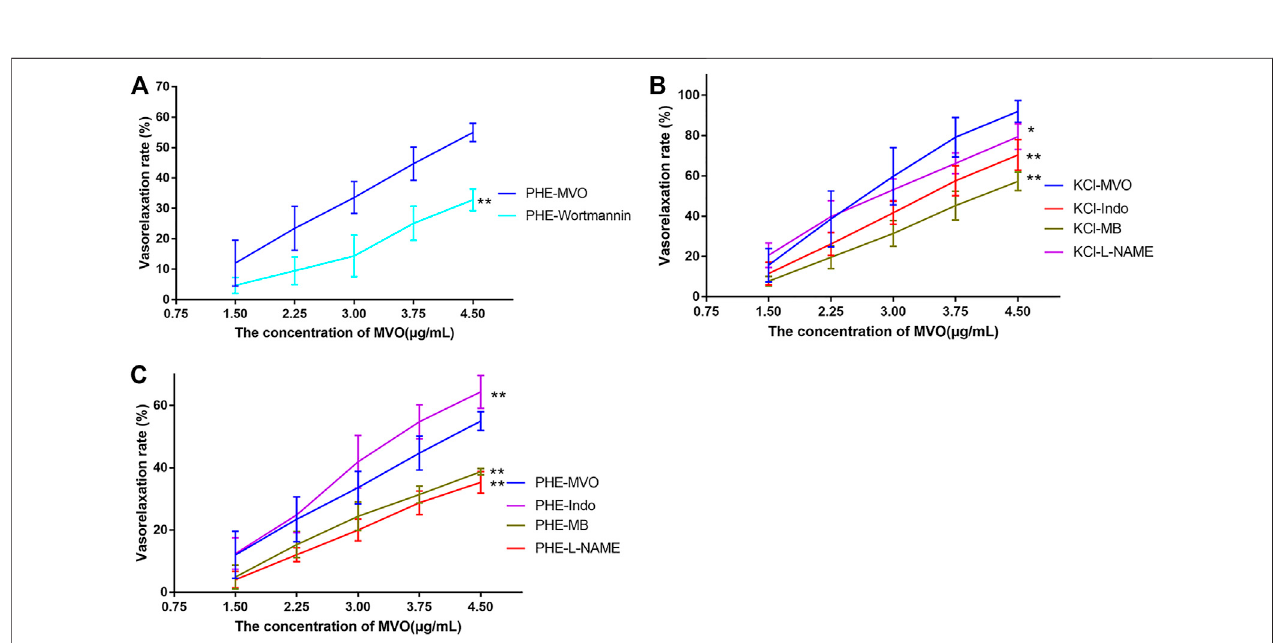
FIGURE 7 | Effects of MVO on rings pre-incubated by different inhibitors. (A) 0.3 μ M wortmannin (a PI3K/Akt inhibitor) precontracted with PHE, 100 μ M L-NAME (anNOSinhibitor),1 μ MIndo(anonselectiveCOXinhibitor),and10 μ M MB(aCOXinhibitor)onMVO-producedrelaxatoryeffectsin+Eaorticringspre-contractedby (B) KCl (60 mM) or (C) PHE (10 μ M). The alternation of tension was expressed as a percentage of the active contraction induced by KCl (60 mM) or PHE (10 μ M). n = 6. Means ± S.D. * p < 0.05, ** p < 0.01 vs. KCl/PHE-MVO group.